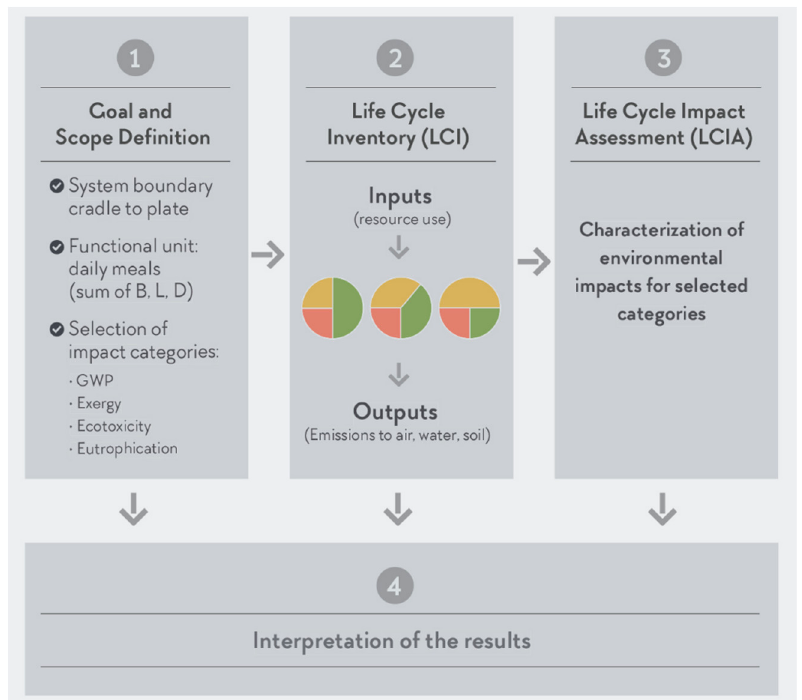
Figure 2. Diagram of the Athlete’s Plate (AP) life cycle assessment phases, with Phase 1 defining the goal (to evaluate the environmental impact (EnvI) of the AP) and scope of the study. The scope includes the system boundary which was defined from cradle to AP. Phase 1 also includes the choice of functional unit (FU), which expresses the data according to the goal of the study. This study used general FUs (per plate; per kg of food on the plate; per 1000 kcal) for comparison purposes. Phase 1 also includes the selection of EnvI categories quantified, which included global warming potential (GWP), exergy, ecotoxicity, and eutrophication. During Phase 2, which focuses on the life cycle inventory (LCI), all the inventories for the different foods were created depending on their inputs and outputs. Phase 3 which is the life cycle impact assessment (LCIA) in which the different inventories were analyzed for the EnvI categories selected. Phase 4 (Results) includes the interpretation of the results.